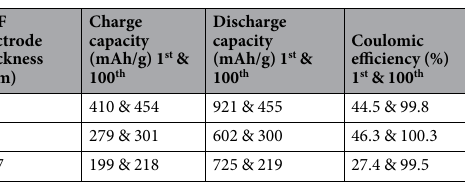
Table 1. Comparison of electrode, charge and discharge capacities, and coulomic efficiency of the ECF electrode at the 1 st and 100 th